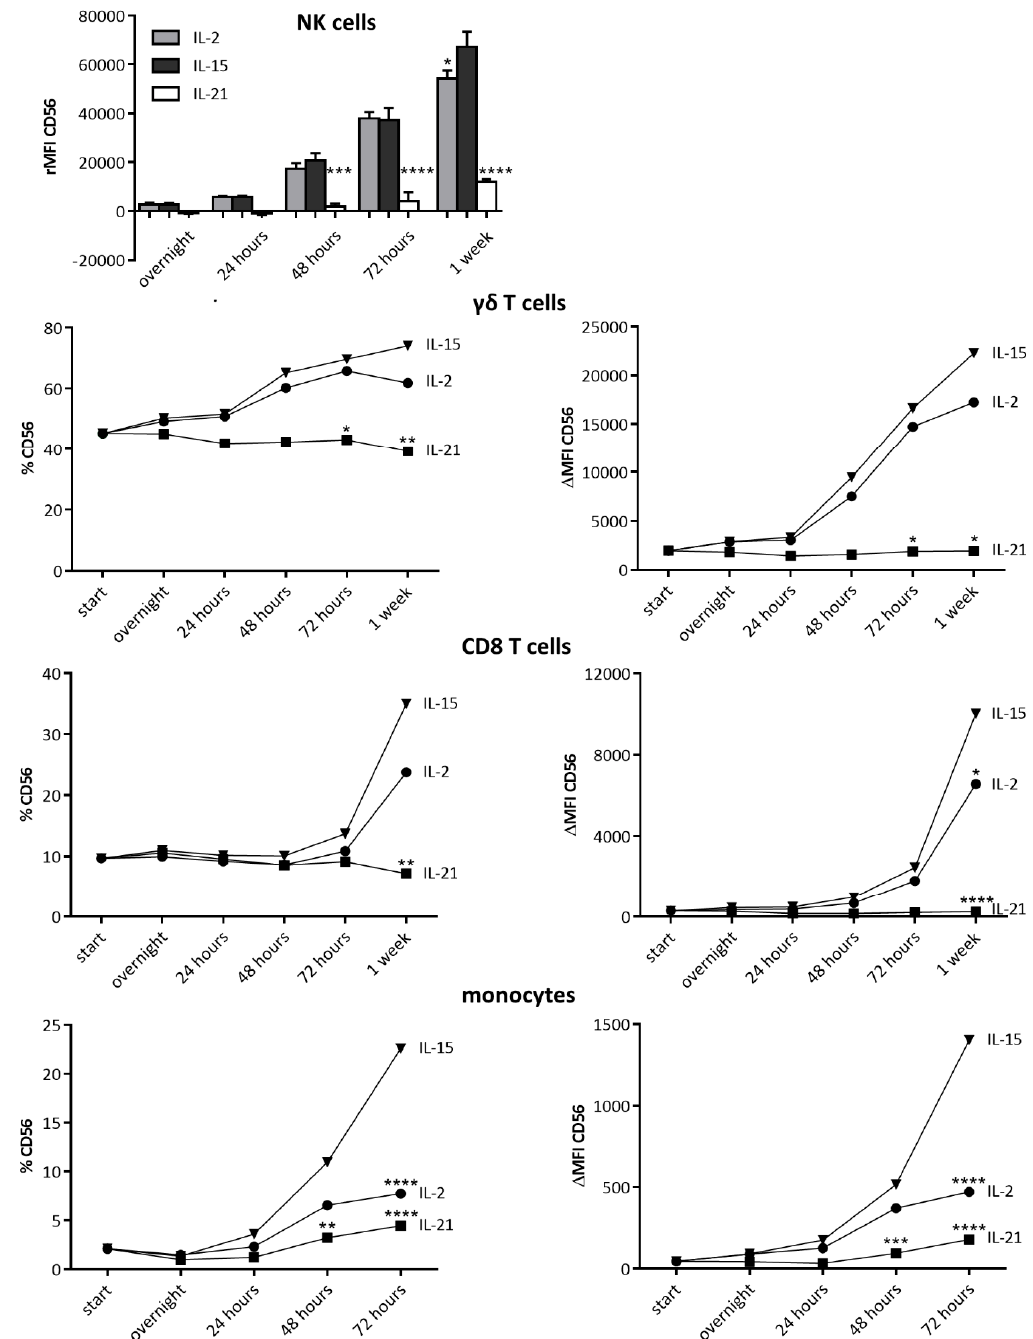
Figure 8. Kinetics of Cluster of di ff erentiation (CD)56 expression following interleukin (IL)-2, IL-15, and IL-21 stimulation. Peripheral blood mononuclear cells (PBMCs) were stimulated with IL-2 (200 IU / mL), IL-15 (10 ng / mL) or IL-21 (20 ng / mL) for di ff erent periods of time, after which CD56 expression